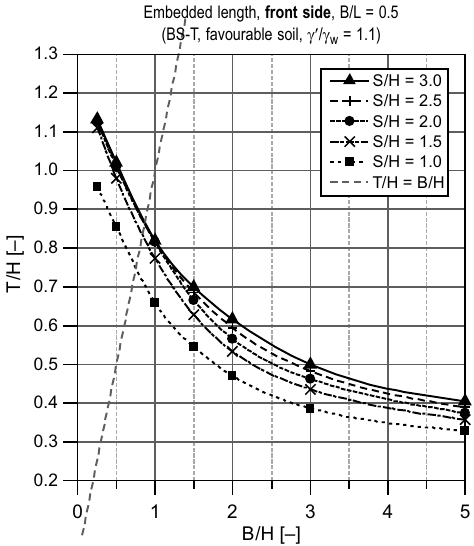
Fig. 6. Design chart for the short side in homogenous, isotropic and favourable soil under three-dimensional conditions